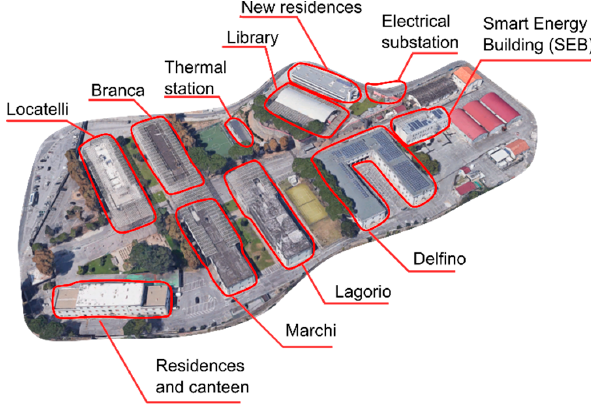
Figure 11. Savona Campus buildings (Genoa University, Italy).